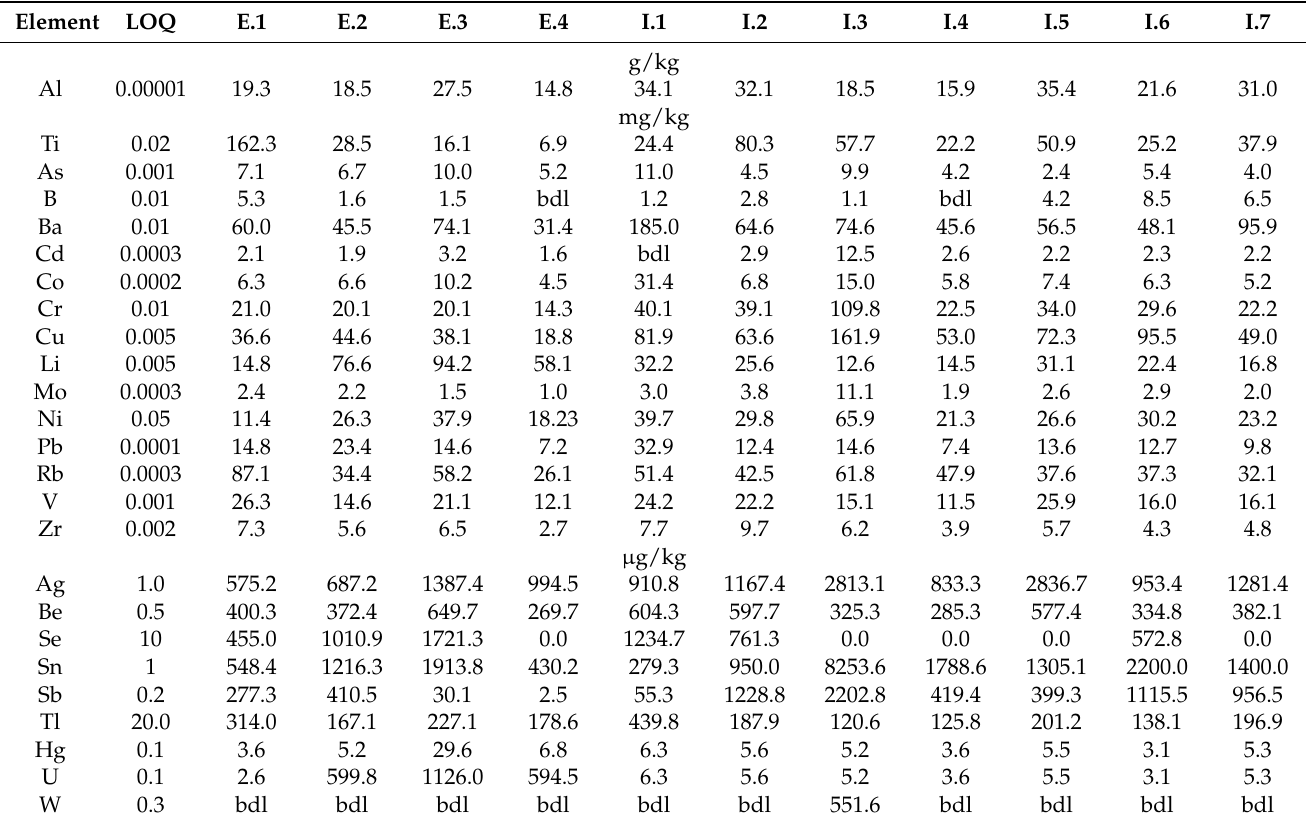
Table 1. Concentrations of Al and trace elements in dusts sampled at the consecutive